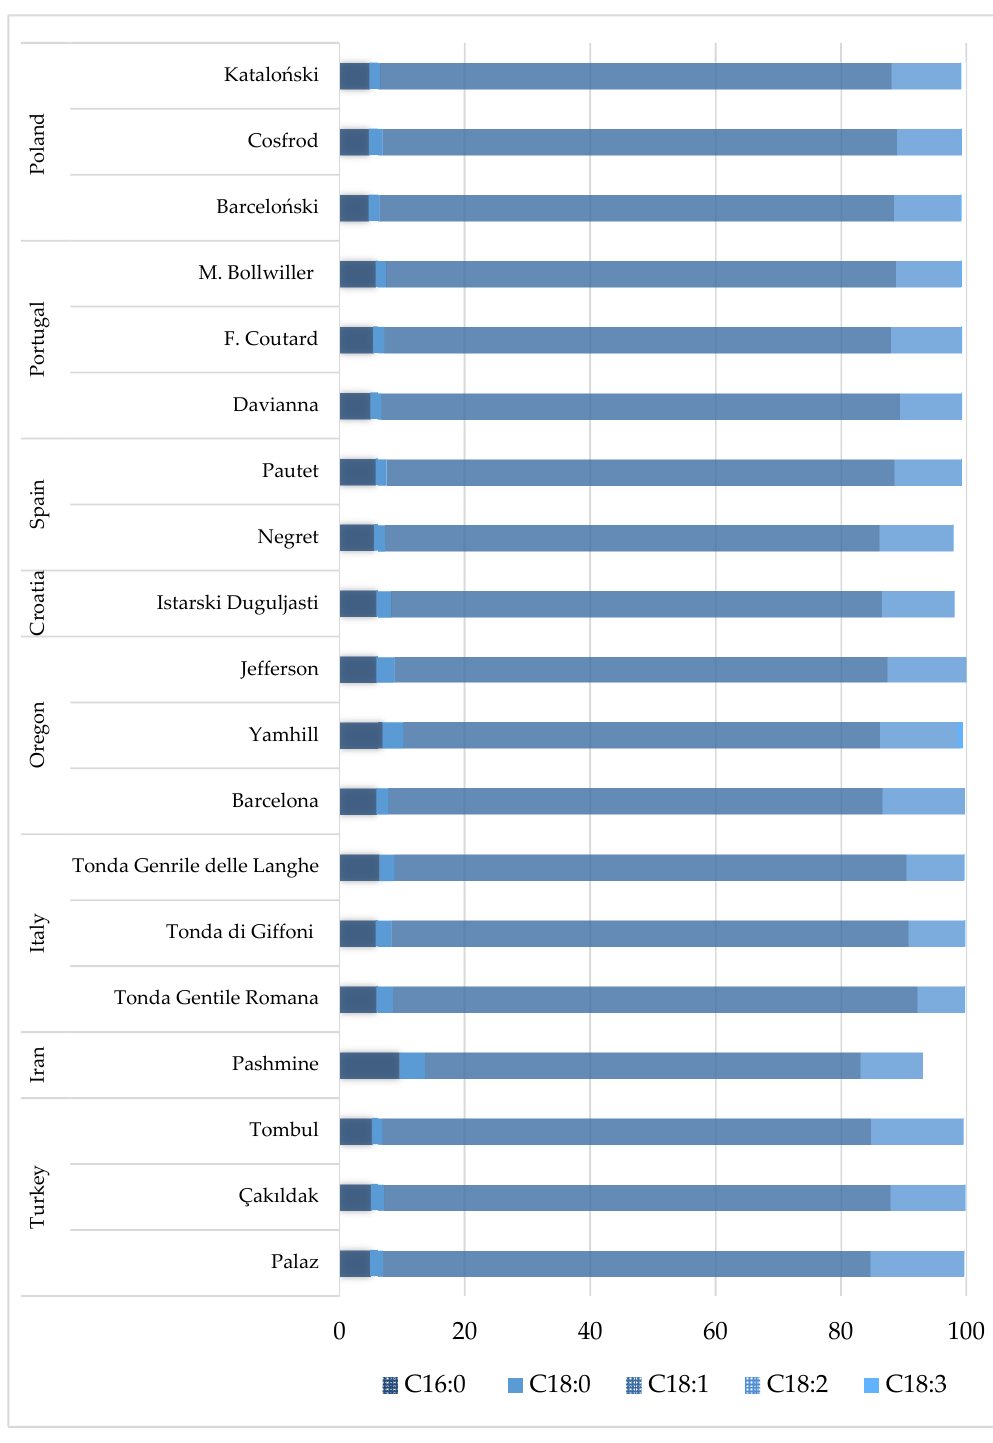
Figure 1. Composition of the main fatty acids (%) in hazelnut from different cultivars and origins. Main fatty acids, where: C16:0—palmitic acid; C18:0—stearic acid; C18:1 c9 —oleic acid; C18:2—linoleic acid; C18:3—linolenic acid. References: Poland: Król et al. [34]; Portugal: Oliveira et al. [9]; Spain: Rovira et al. [50]; Croatia: Vujevic et al. [67]; Oregon: Wang et al. [62]; Italy: Bacchetta et al. [54]; Iran: Rezaei et al. [33]; Turkey: Koksal et al. [27].